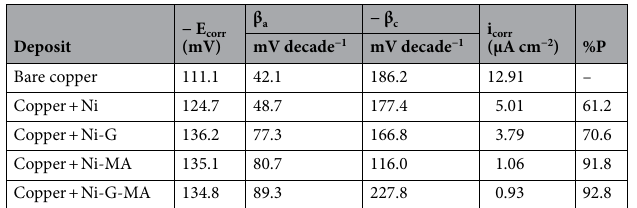
Table 1. Potentiodynamic polarization parameters for bare copper and coated copper by Ni, Ni-G, Ni-MA, and Ni-G-MA in 0.5 M NaCl solution.